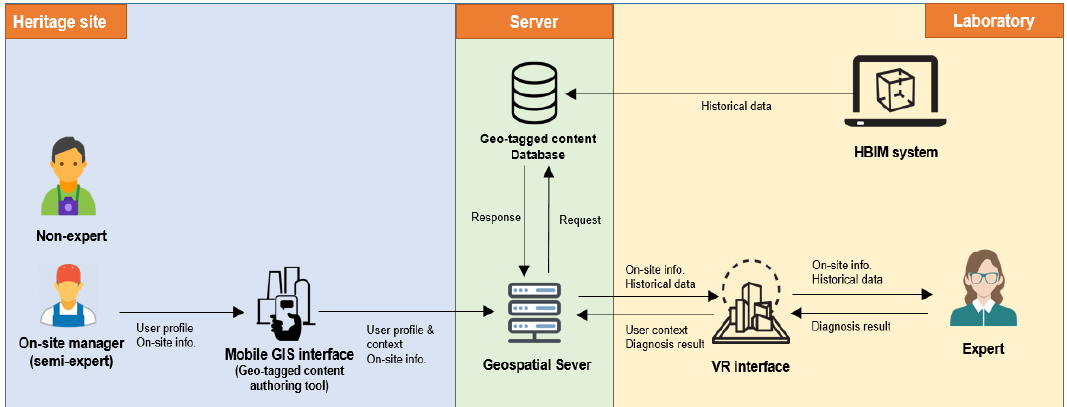
Figure 6. A framework of remote diagnosis in virtual reality.